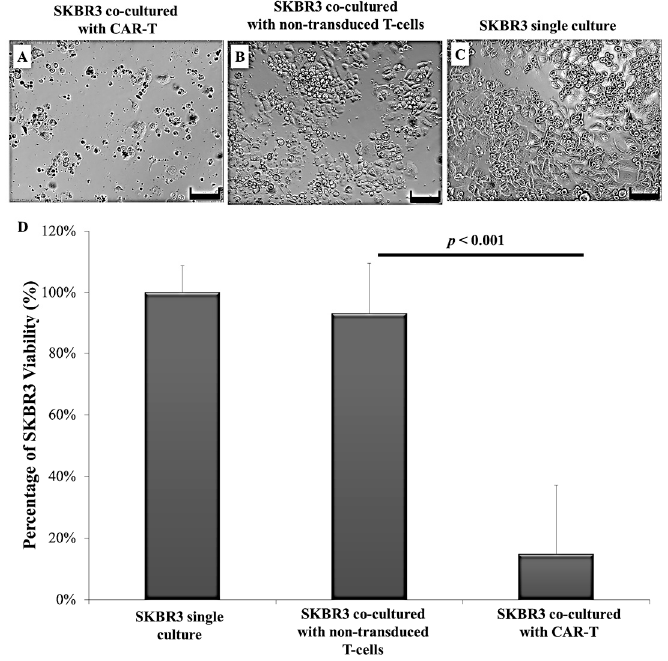
Figure 5. Detection of efficiency of CAR-T cells in SKBR3 cell lysis. The effectiveness of CAR-T cells and non-transduced T-cells in the lysis of SKBR3 cells was observed by phase contrast microscopy and measured by the CellTiter 96 Cell Proliferation Assay (MTS). ( A ) Phase contrast image of SKBR3 co-cultured with CAR-T cells. The image showed a minimal amount of attached SKBR3 cells on the plate, indicating low cell viability; ( B ) phase contrast image of SKBR3 co-cultured with non-transduced T-cells. The image showed high numbers of attached SKBR3 cells on the plate, indicating high cell viability; ( C ) phase contrast image of SKBR3 single culture. The image showed high numbers of attached SKBR3 cells indicating high cell viability. Cells were visualized by inverted light microscopy. Cells were imaged at 100 × magnification (the scale bar represents 200 µ m); ( D ) the graph indicates that cell viability of SKBR3 cells co-cultured with CAR-T ( n = 7) was extremely low compared to that of SKBR3 cells co-cultured with non-transduced T-cells ( n = 6) or SKBR3 single culture cells ( n = 6). Statistical analysis showed an extremely low p value of <0.001 for co-culture with CAR-T cells compared to non-transduced T-cells or SKBR3 single culture. The percentage of viable SKBR3 cells that remained attached to the plate was only 14.84% in CAR-T co-cultured with SKBR3 cells compared to 93.2% in SKBR3 cells co-cultured with the non-transduced T-cell. The SKBR3 single culture was observed to show 100% cell viability. The X-axis indicates the experimental groups while Y-axis indicates the percentage of SKBR3 cell viability. MTS data was reported as a bar chart of the experimental mean ± standard error of the mean (S.E.M) with p < 0.001 with respect to the experimental SKBR3 cell viability upon co-culture with CAR-T cells compared to non-transduced T-cells by ordinary one-way ANOVA analysis.